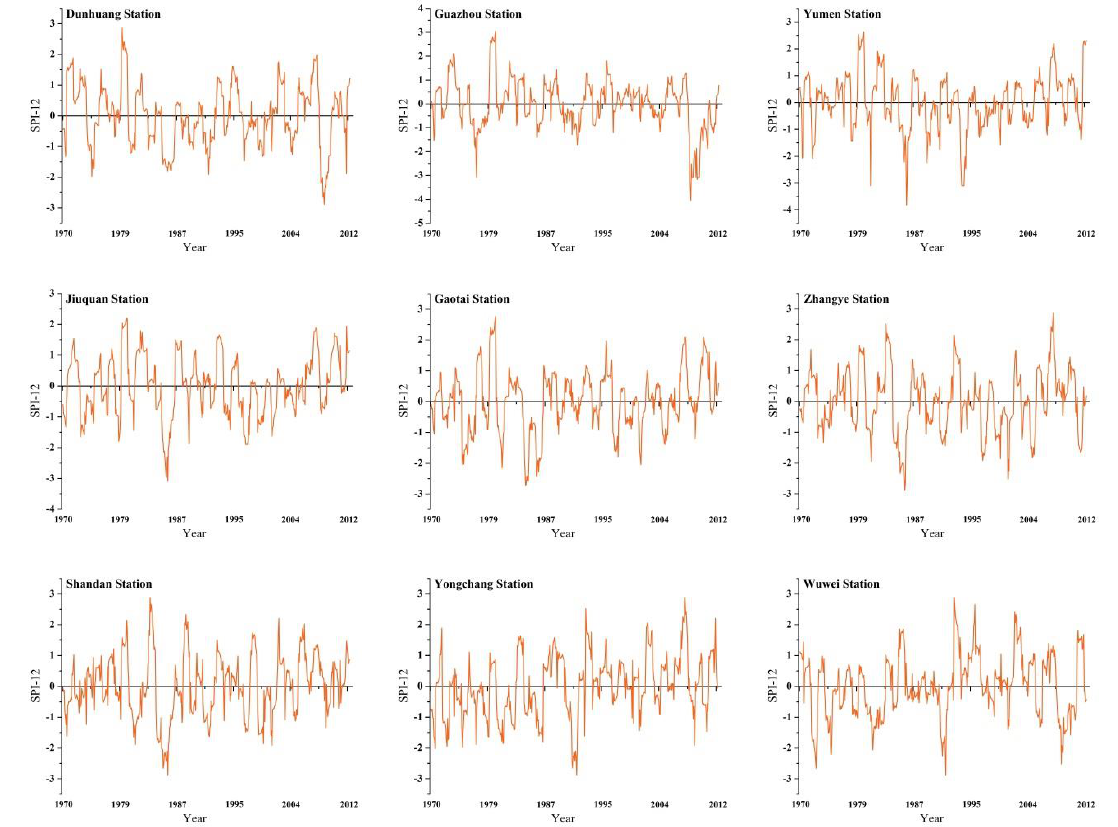
Figure 2. SPI-12 at the nine meteorological stations during 1970–2012.